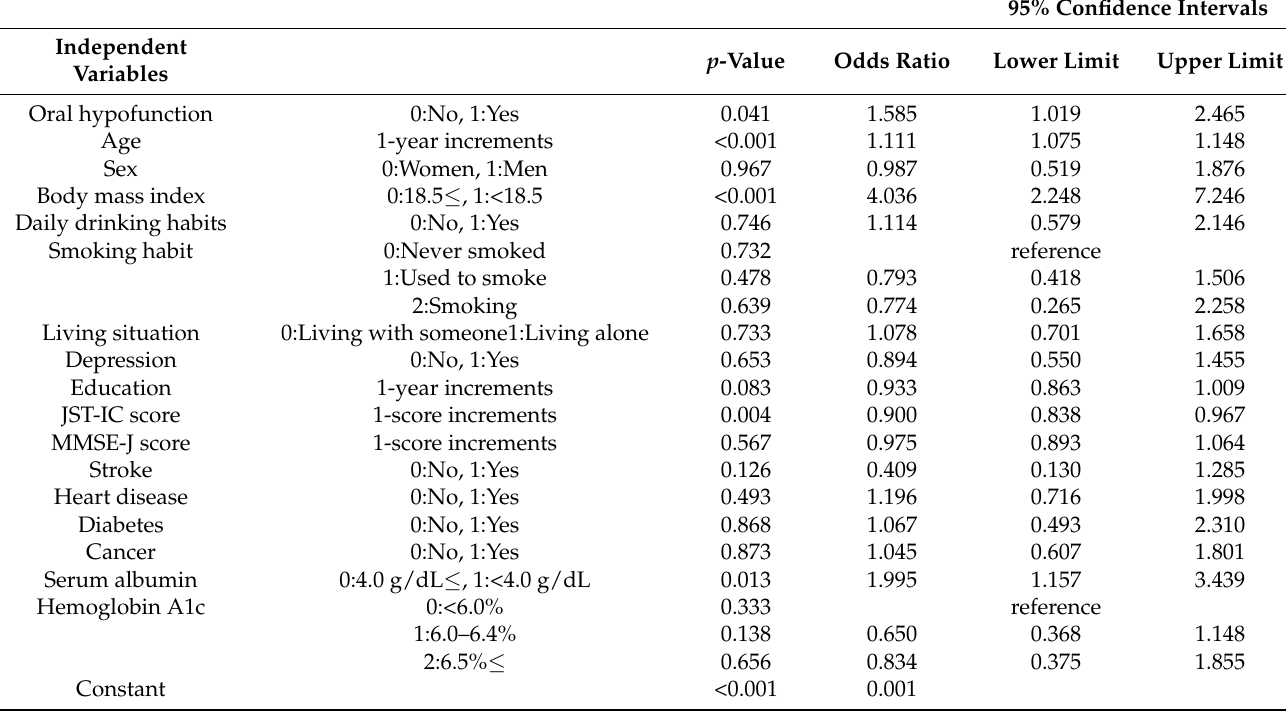
Table 3. Multivariable logistic regression analysis with sarcopenia as the dependent